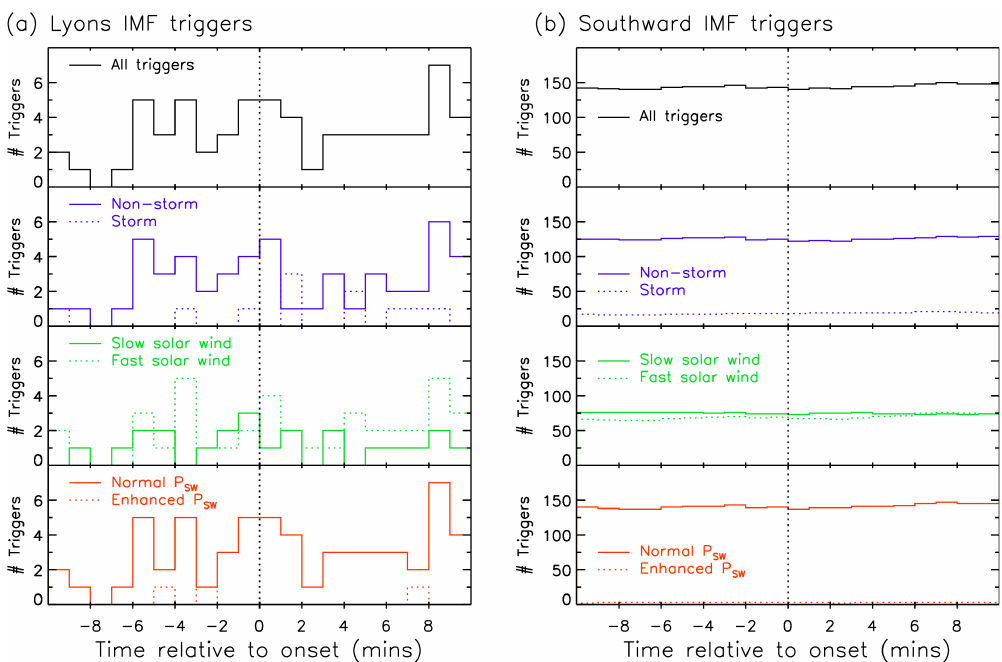
Fig. 3. The occurrence of substorm triggers within ± 10min of substorm onset based upon (a) all four Lyons et al. (1997) criteria and (b) triggers satisfying only the first (southward IMF) criterion. In both cases, the panels present (from top to bottom) the occurrence within the parent distribution of all substorm onsets; occurrence during storm and non-storm intervals; occurrence during intervals of fast and slow solar wind; occurrence during intervals with changes in solar wind dynamic pressure (as described in the